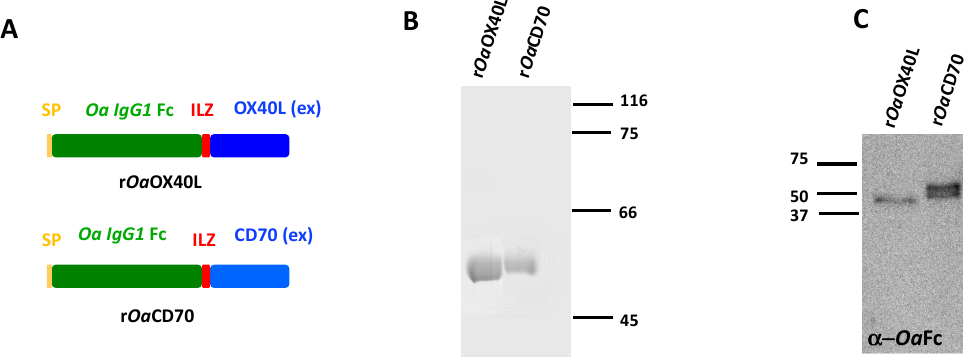
Figure 1. Purification of recombinant proteins r Oa OX40L and r Oa CD70. ( A ) Schematic representation of the protein constructs expressed by the recombinant baculoviruses and adenoviruses. They include an insulin derived signal peptide (SP) the ovine (Oa) IgG1 Fc domain, the short isoleucine trimerization domain (ILZ) followed by either the predicted extracellular domain from ovine OX40L or ovine CD70. ( B ) Coomassie-blue stained SDS-PAGE showing immunoaffinity purified recombinant proteins. Molecular Weigth Marker in kilodaltons (kDa) are shown on the right. ( C ) Western blot analysis of the purified proteins detected by an anti-ovine Fc antibody. MWM (kDa) are shown on the left.